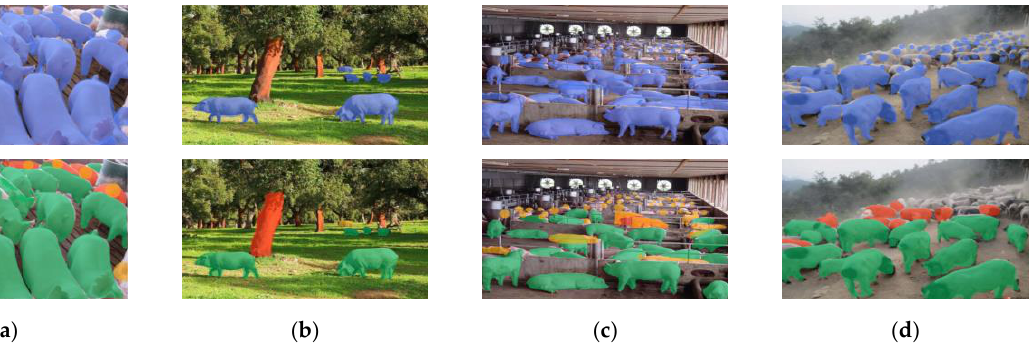
Figure 14. Results of false and missing segmentation. ( a ) missing segmentation indoors; ( b ) mis-segmentation outdoors; ( c ) mis-segmentation indoors; ( d ) missing segmentation